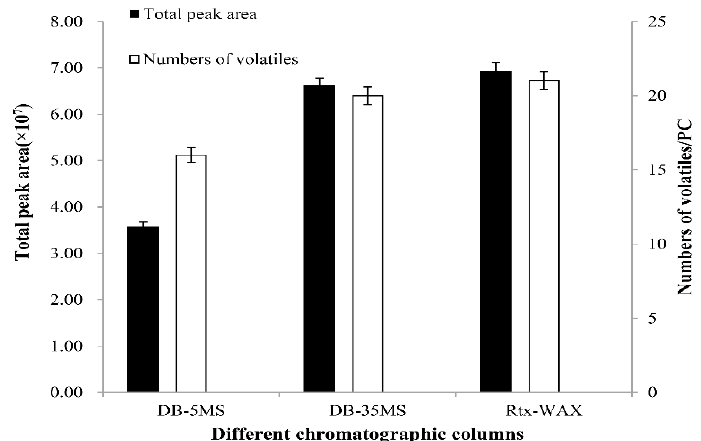
Figure 1. Total ion chromatogram by different chromatographic columns.